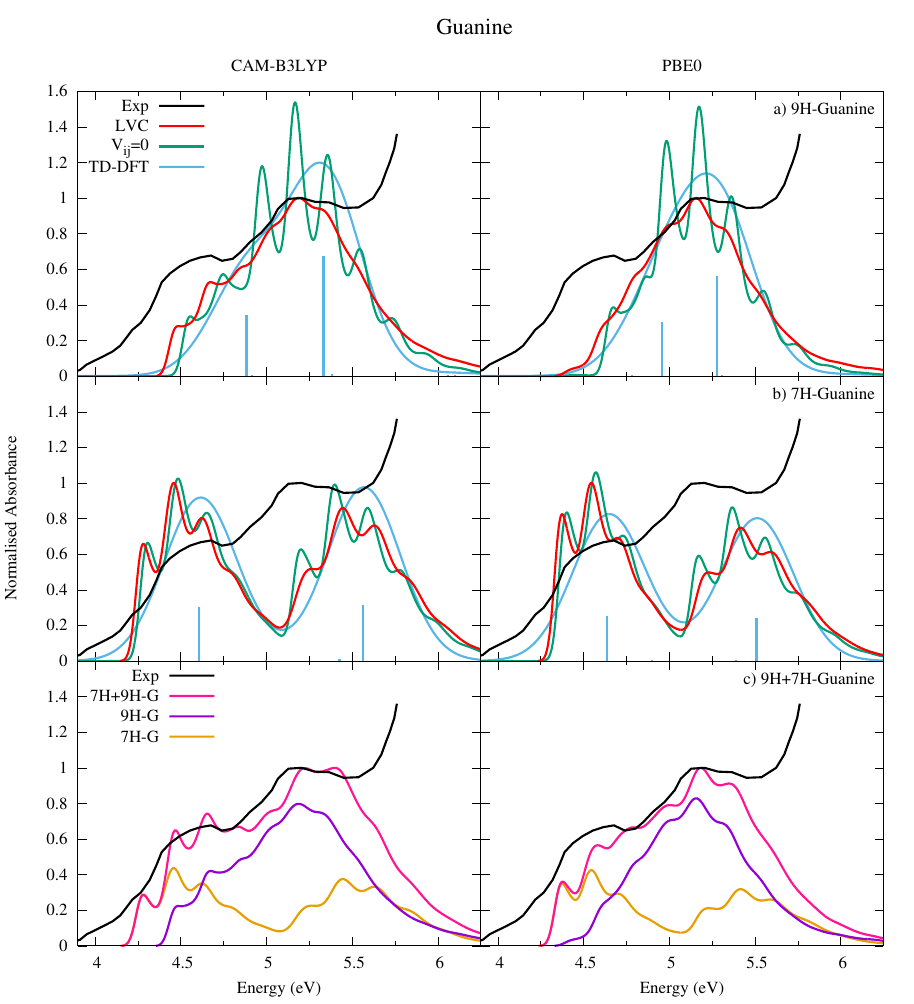
Figure 9. Absorption spectra of ( a ) 9H-Guanine and ( b ) 7H-Guanine from the LVC model (red), without inter-state coupling (green), TD-DFT calculations with stick spectra (blue), and experimental data (black) [53]. Most intense peak from experiment and LVC spectra normalised to 1, with other calculated spectra normalised with the same value as LVC spectra. Panel ( c ) shows the combination (pink) of 9H (purple) and 7H (orange) LVC spectra compared to experiment (black). Most intense peak from experiment and 7H-9H combination normalised to 1. Individual 7H and 9H spectra normalised with same value as 7H-9H combination. For all panels CAM-B3LYP spectra on the left red-shifted by 0.3 eV, PBE0 spectra on the right red-shifted by 0.08 eV. LVC spectra broadened with Gaussian HWHM 0.04 eV, TD-DFT with HWHM 0.25